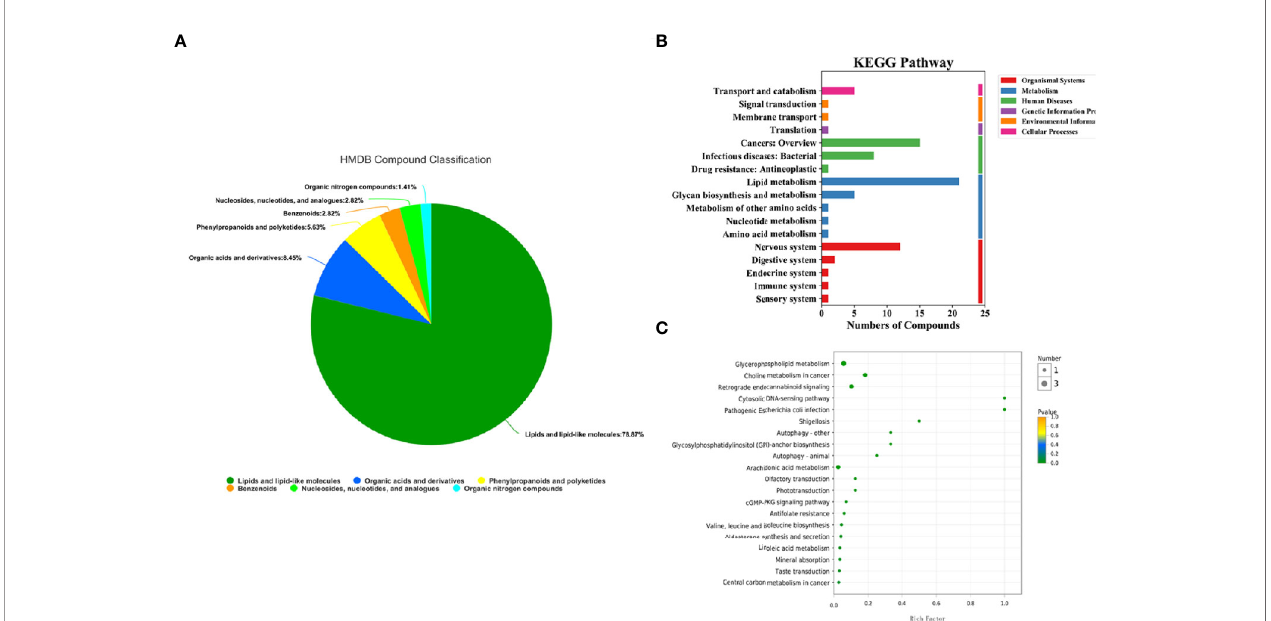
FIGURE 4 | HMDB compound classi fi cation and KEGG pathway analysis of serum metabolites in the lung cancer group and healthy control group. (A) HMDB compound classi fi cation of serum metabolites between the lung cancer group and the healthy control group. (B) Serum KEGG pathways between the lung cancer group and the healthy control group. (C) KEGG enrichment pathways for serum metabolites in the lung cancer group and the healthy control group.